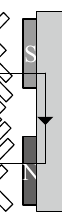
Figure 6 Magnetic circuit of a coreless torus-NS